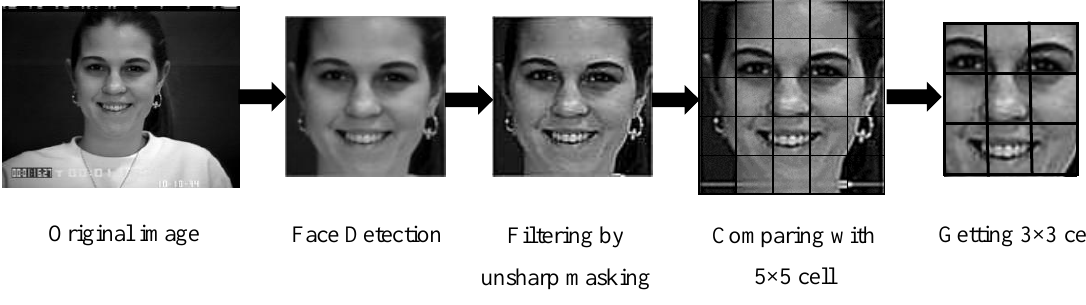
Figure 2. Pre-processing steps.